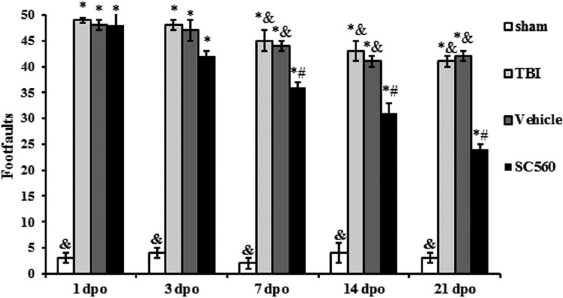
Figure 2. Effects of SC560 on fine motor coordination evaluated by the beam walk test after traumatic brain injury (TBI). TBI caused significant deficits in fine motor coordination (sham vs TBI and vehicle groups, P , 0.001). However, there was no significant difference between the TBI group and the vehicle group throughout the experiment (P . 0.05). SC560 treatment significantly altered beam walk performance from 7 dpo compared with that of the TBI and vehicle groups (P , 0.05). Data are reported as means±SD (n=8). dpo; days post operation. & P , 0.05, compared to SC560- treated group; *P , 0.05, compared to sham group; # P , 0.05,